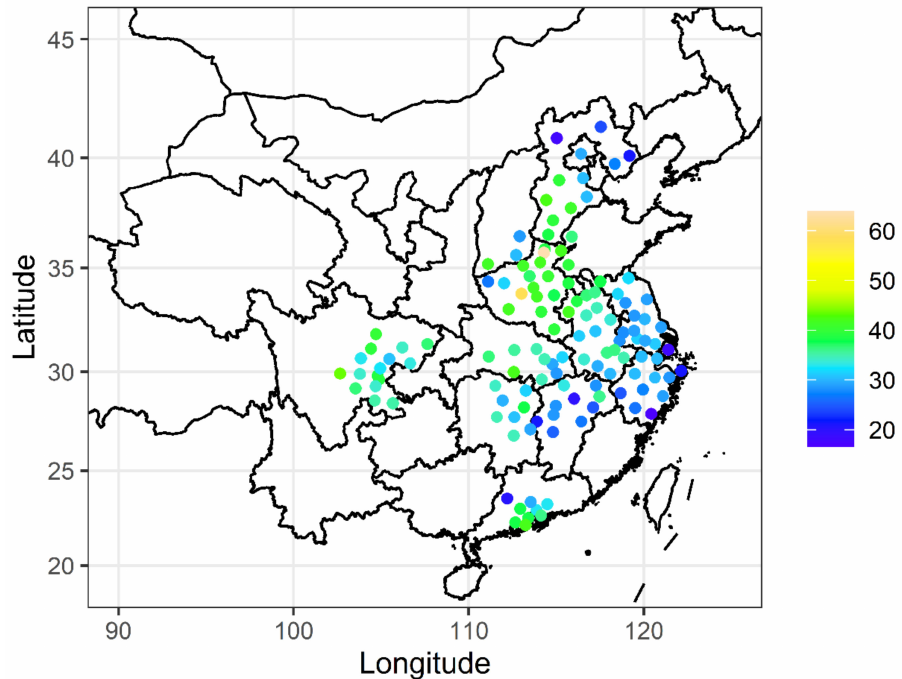
Figure 8. The variance contribution of the fitting values from meteorological factors to the observed PM 2.5 concentrations in six urban agglomerations during the period of